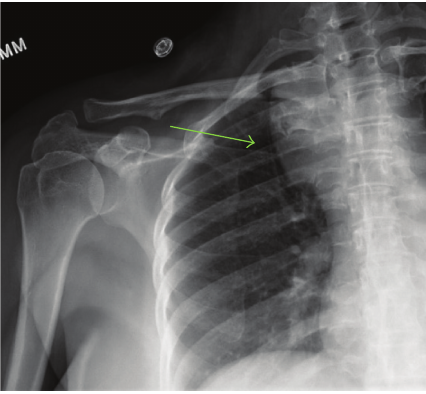
Figure 1: Frontal radiograph of the right shoulder shows a superior mediastinal mass (green arrow) within the right hemithorax.